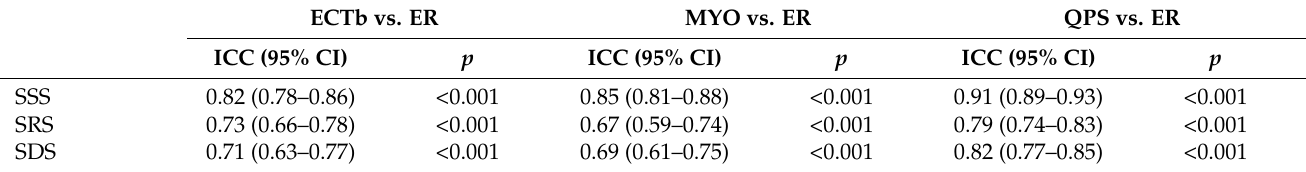
Table 3. ICCs for SSS, SRS and SDS between ER and ECTb, MYO, and QPS software